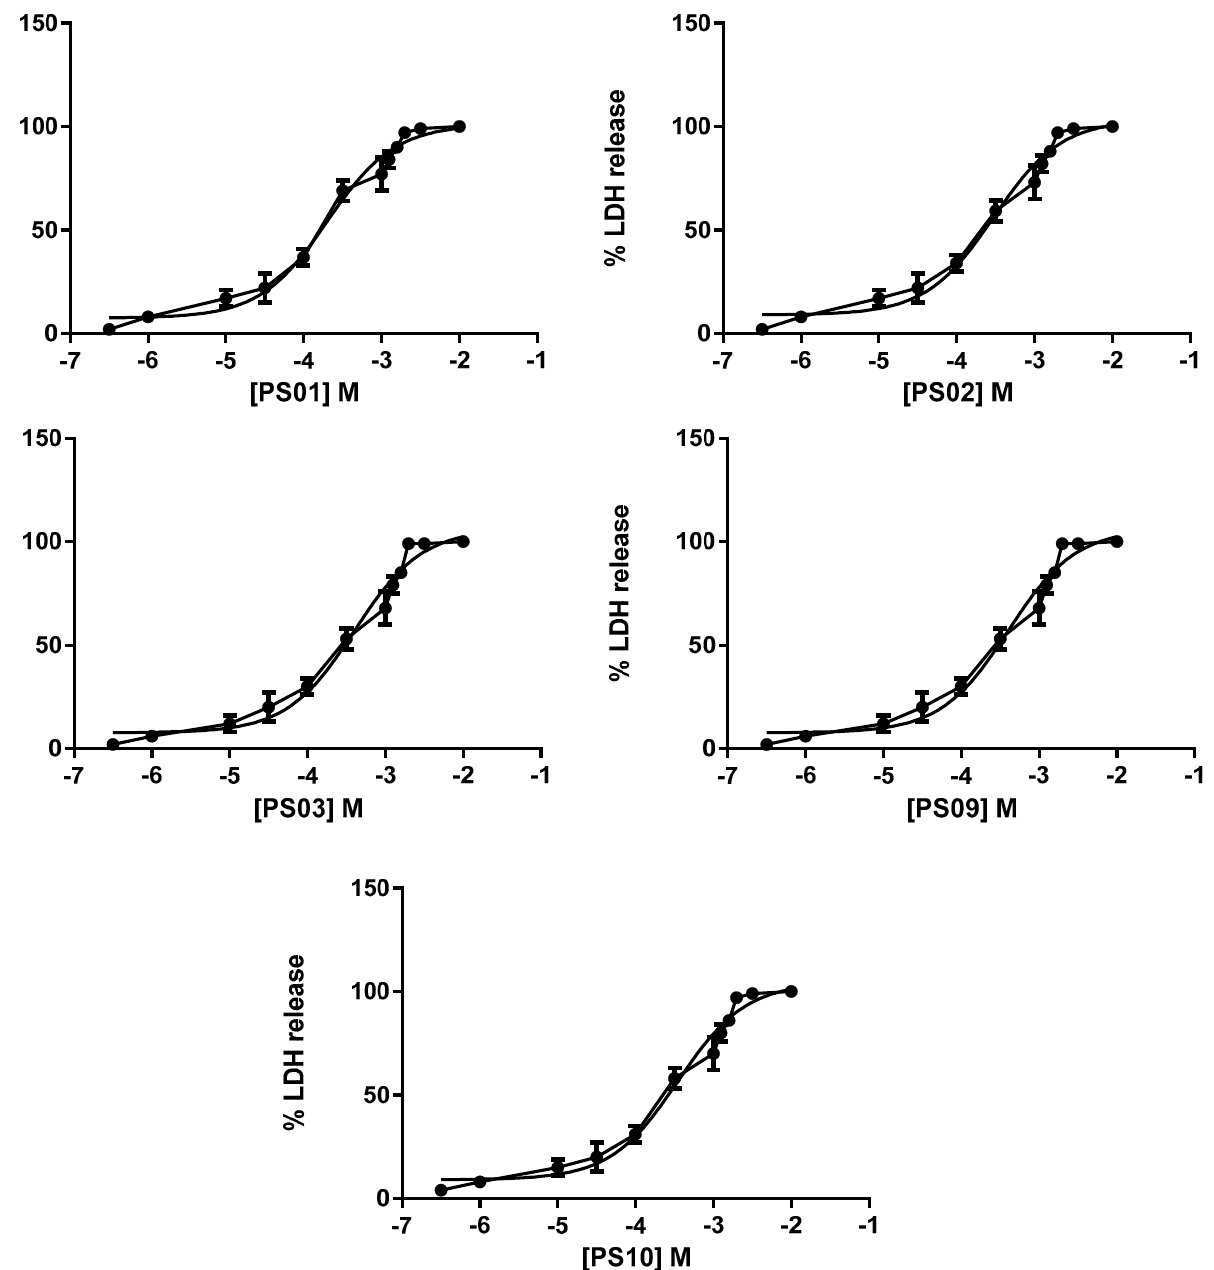
Figure 5. Dose-response curve for the sulfonamides. Peritoneal macrophages were pretreated for 24 h with sulfonamides at crescent concentrations. The error bar is representative of 3 experiments in triplicate on 3 different days. M—drug concentration.